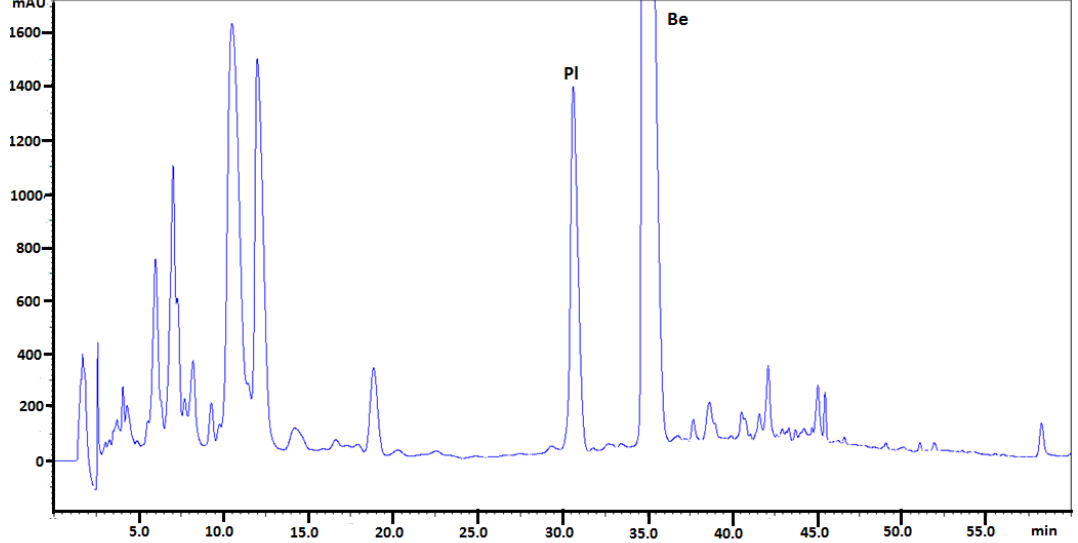
Figure 3. Chromatogram obtained for Mahonia aquifolium cortex extract obtained on Polar Reversed Phase (Polar RP) column with mobile phase MeCN, water and 1-butyl-3-methylimidazolium tetrafluoroborate. Abbreviations: Pl—palmatine, Be—berberine. Plant material was collected during flowering.